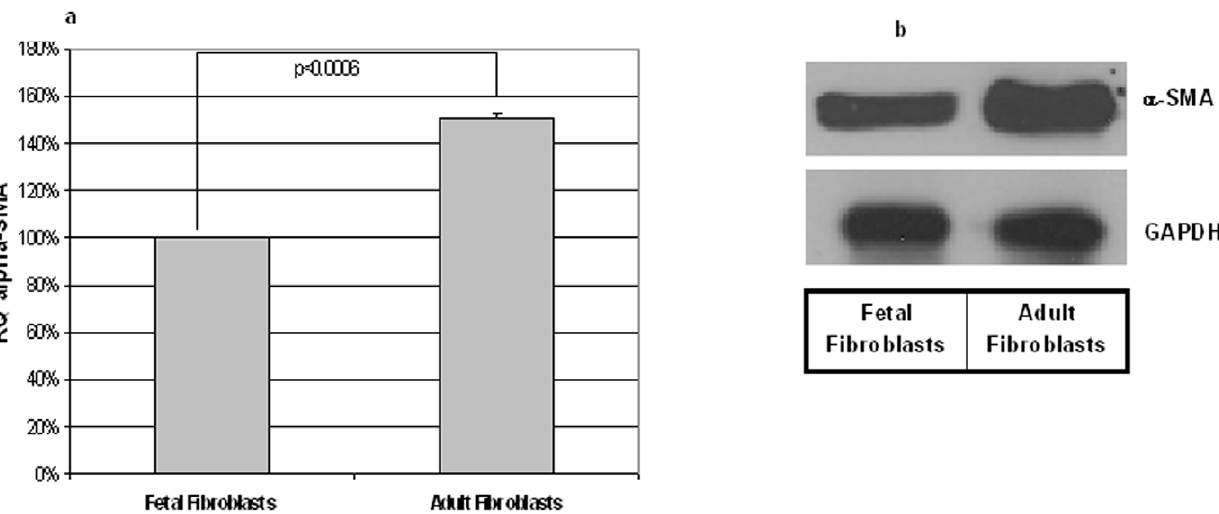
Figure 9. siRNA downregulation of CCT-eta but not CCT-beta reduces a -SMA protein levels in adult fibroblasts. (a & b)Western blot showed effective reduction of both CCT-eta and a -SMA protein levels when CCT-eta siRNA was administered, leaving beta-actin largely unaffected. In contrast, downregulating CCT-beta did not lead to significant reduction in either a -SMA or beta-actin levels. GAPDH was used as loading internal control. A representative immunoblot of up to three similar such blots are shown for each analysis. Ntx- no transfection; EGF-EGF treatment (1 nM); siRNA-treatment with CCT-eta/CCT-beta siRNA; Scr- treatment with scrambled control siRNA.